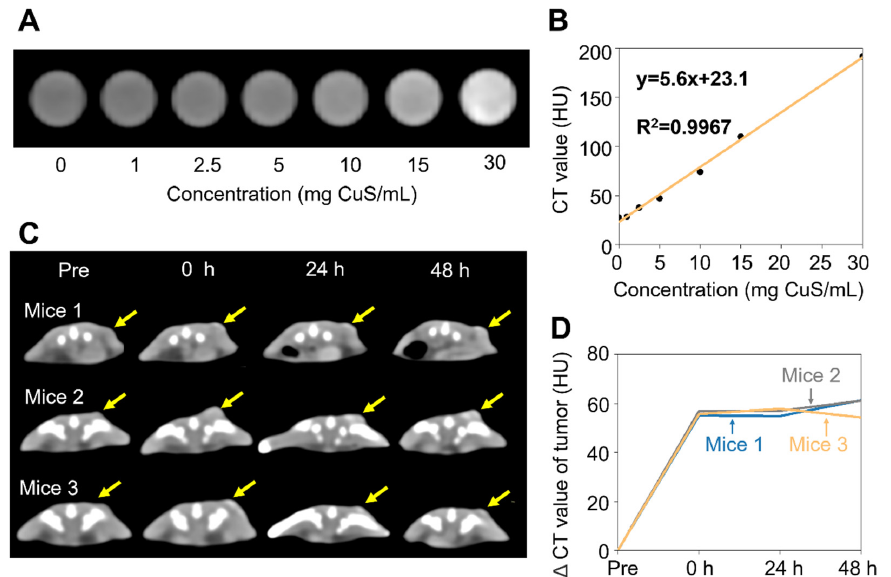
Figure 5. ( A ) CT images of CSH at different concentrations. ( B ) CT value curve of CSH. ( C ) CT scan of BALB/c mice before and 0, 24, and 48 h after being intratumorally injected with 20 mg CuS/mL of CSH ( n = 3). ( D ) CT value (Hounsfield, HU) changing curves on the tumor site of BALB/c mice.